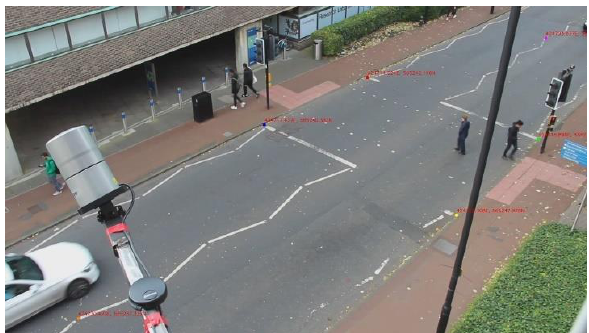
Figure 2. Original camera view with selected coordinates (red)